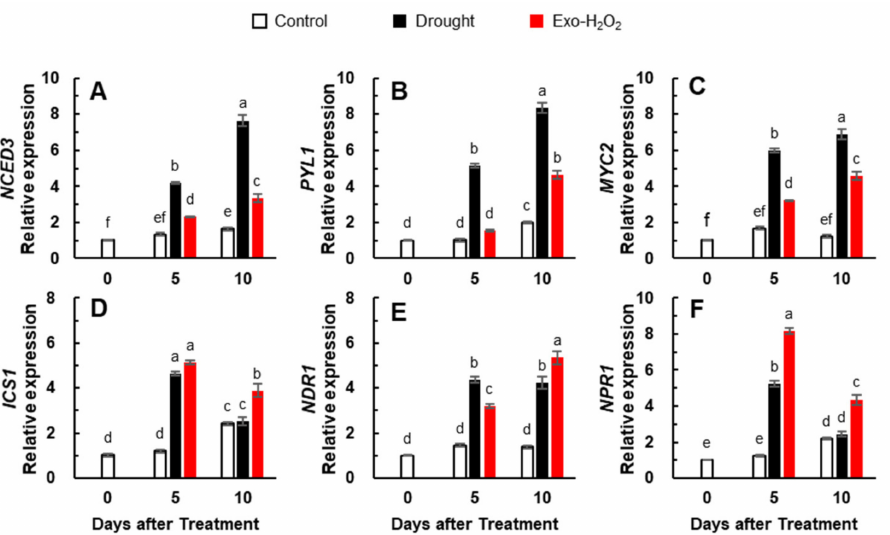
Figure 2. Changes in the expression of ( A ) ABA synthesis-related gene NCED3 , ( B ) ABA receptor gene PYL1 , ( C ) ABA signaling-related gene MYC2 , ( D ) SA synthesis-related gene ICS1 , ( E ) NDR1 , and ( F ) SA signaling-related gene NPR1 in the leaves of control, drought-, or exogenous H 2 O 2 (Exo- H 2 O 2 )-treated plants for 10 days. Results are represented as mean ± SE for n = 3. Different letters indicate values that are significantly different at p < 0.05 according to Duncan’s multiple range